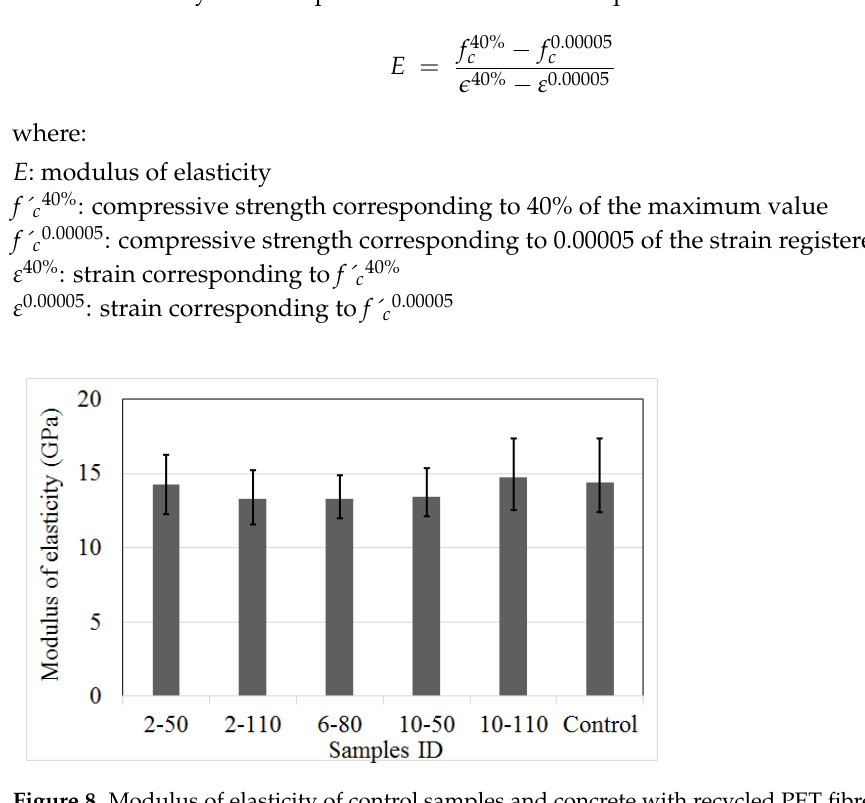
Figure 8. Modulus of elasticity of control samples and concrete with recycled PET fibres.